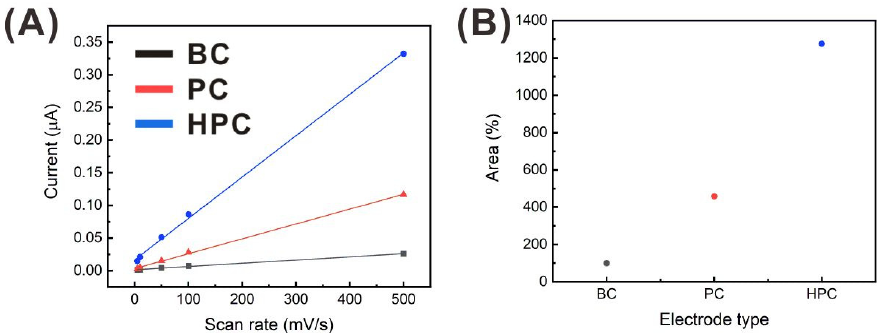
Figure 4. ( A ) Capacitive current difference at the middle of the potential window, according to the